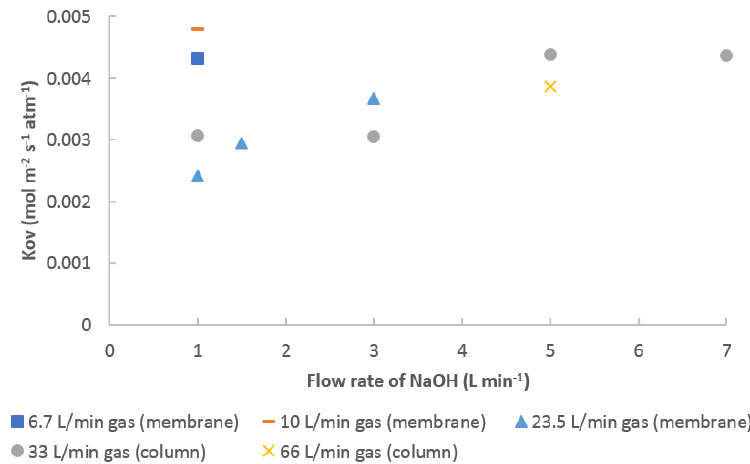
Figure 4. Mass transfer coefficient in function of the NaOH flow rate for different flue gas flow rates in the two set ups. The CO 2 and NaOH initial concentrations are 10% and 0.2 mol L −1 , respectively, for all the cases except the experimental point corresponding to 23.7 L min −1 gas (membrane) and 3 L min −1 of NaOH flowrate, where it was used as 15% of CO 2 .